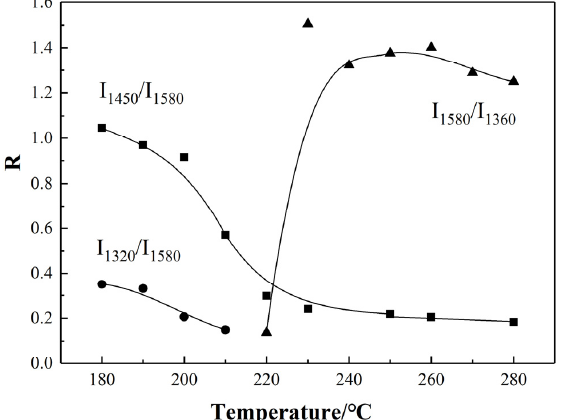
Figure 2. Variation of characteristic structure for PAN thermal-stabilized fibers with temperature.